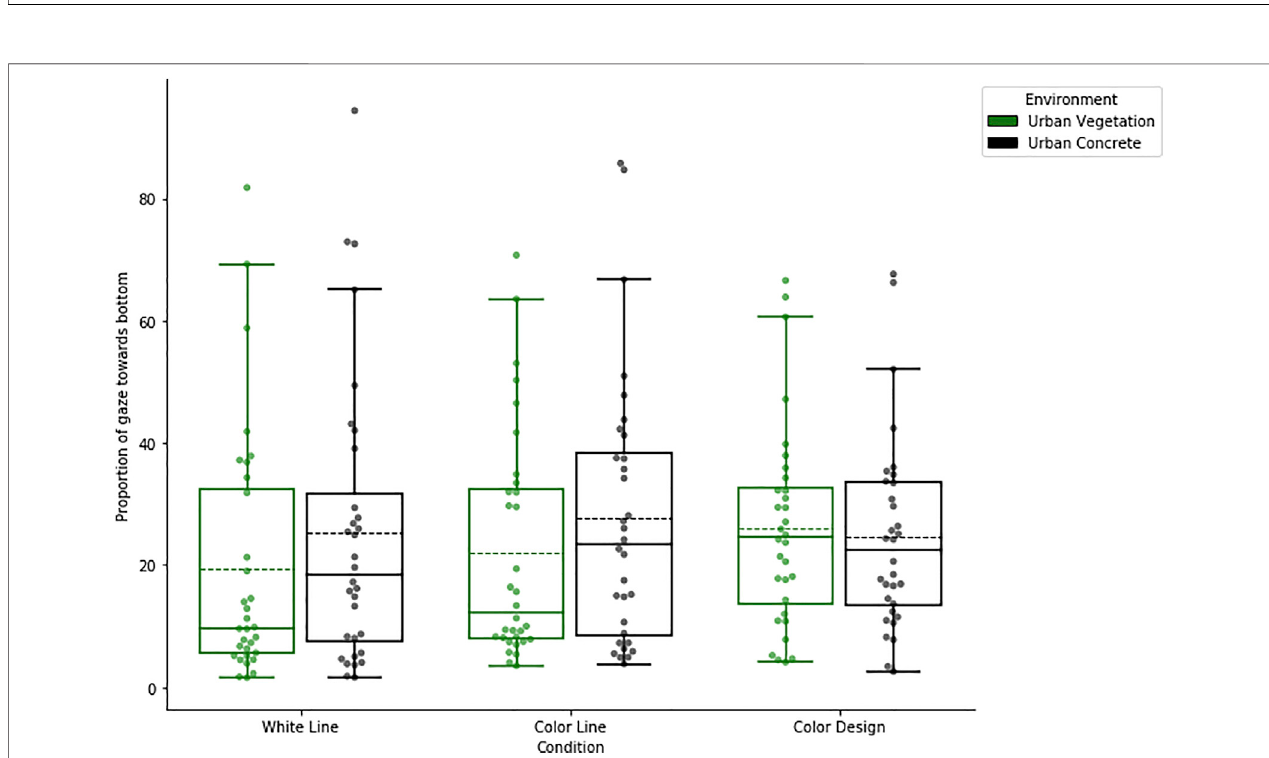
FIGURE 9 | Bar charts illustrating the impact of Environment (Concrete vs . Vegetation) on the proportion of time spent looking towards the ground during spontaneous walking in the six urban virtual environments.